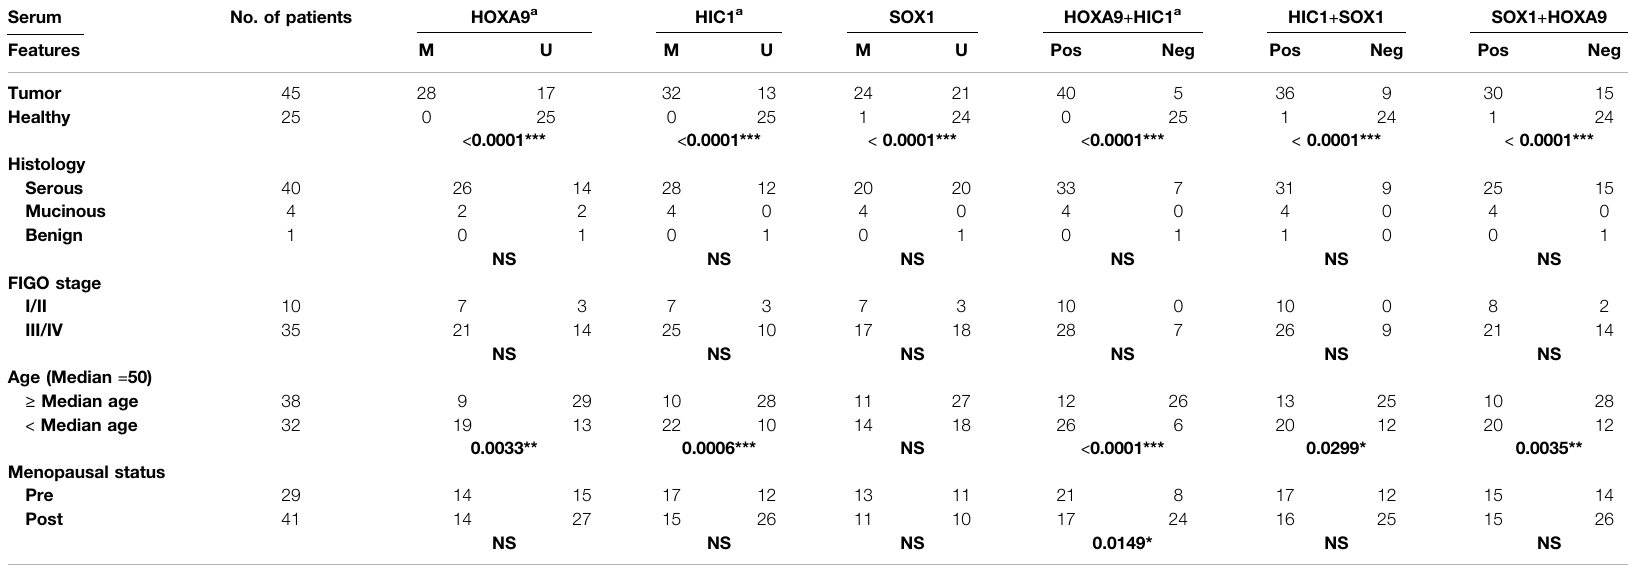
TABLE 5| Association ofpromoterhypermethylation status ofcandidate geneswithpatient ’ sclinico-pathological features inEOCserum samples. p -value: Pearson ’ schi-square and Fisher ’ sexacttests. Abbreviation: Pos: biomarker panel positive for methylation; Neg: biomarker panel negative for methylation; NS: not signi fi cant. A positive biomarker panel is de fi ned as when either or both gene promoter show methylation. Serum Features